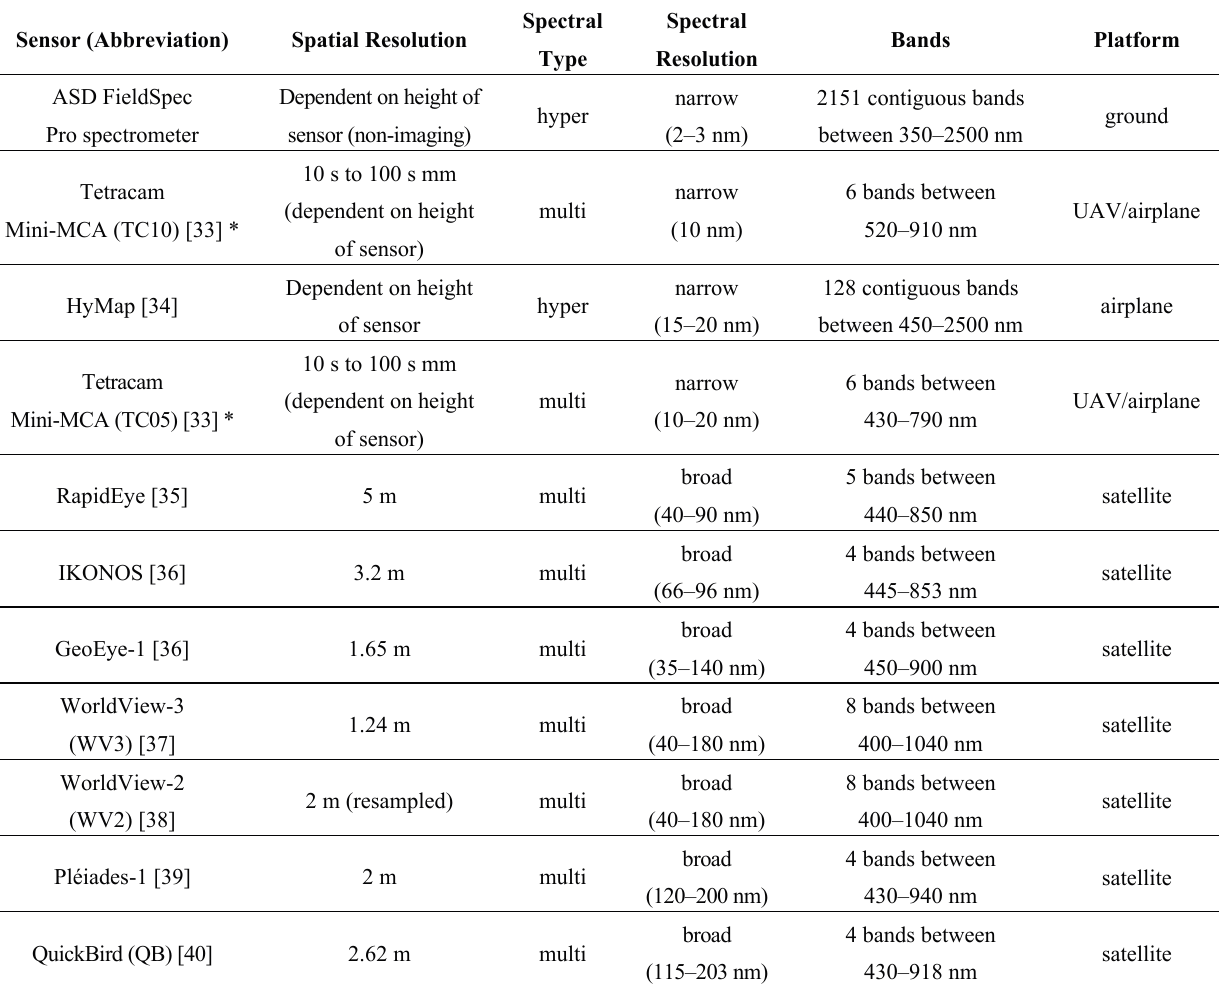
Table 1. Details of sensors used in this study (in order of maximum band width from narrowest to